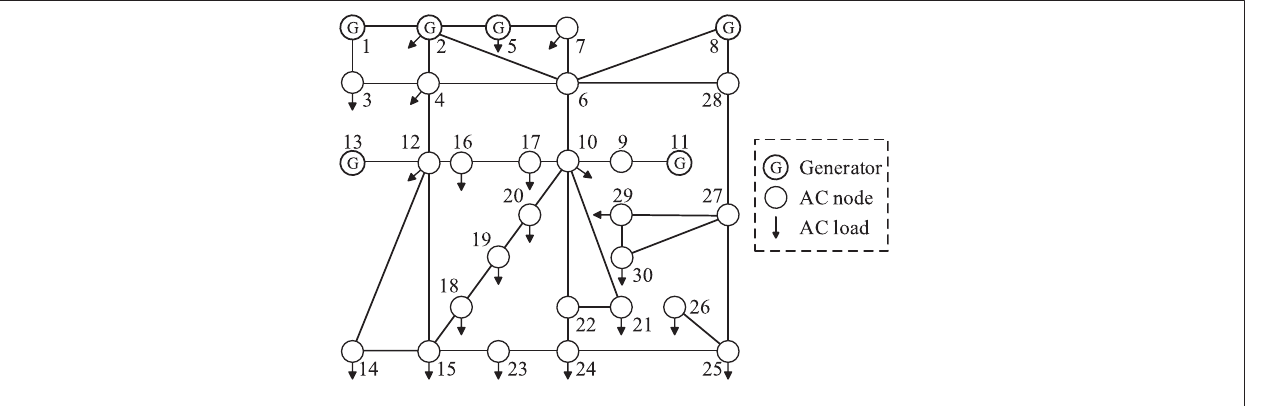
FIGURE 3 | Schematic diagram of IEEE 30-node system.